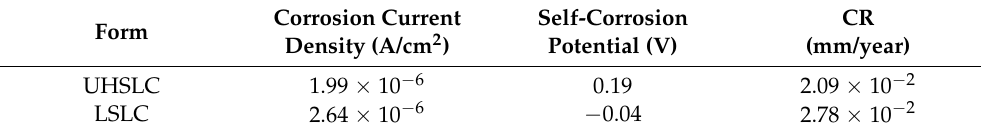
Table 4. Polarization curve parameters of Inconel625 alloys coatings prepared by UHSLC and LSLC. Corrosion Current Form Density (A/cm 2 )